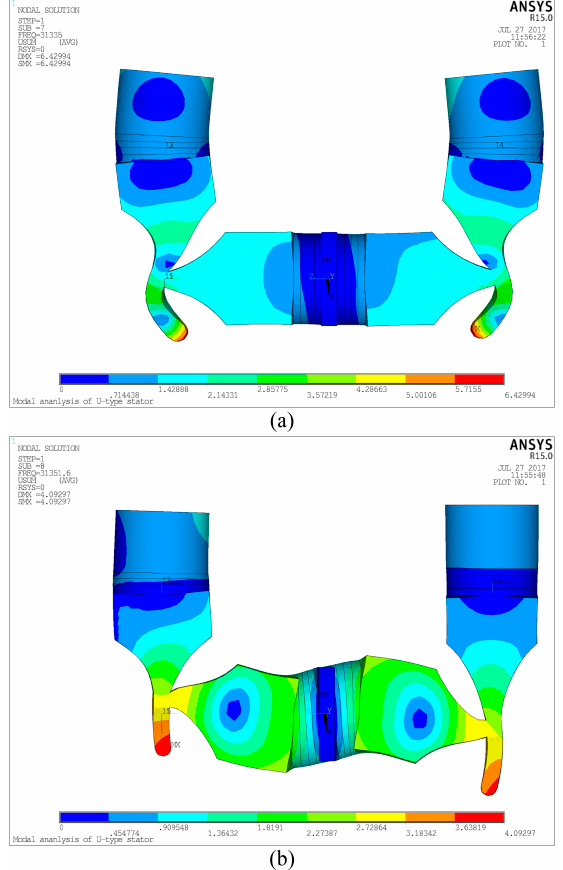
Figure 3. Vibration modes of the PUM: ( a ) Mode A; and, ( b ) Mode B.